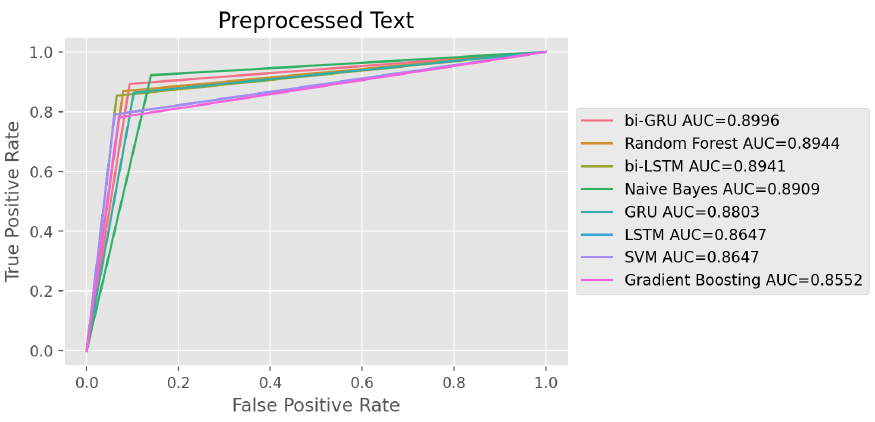
Figure 8. ROC curve and AUC of proposed models when applying text preprocessing